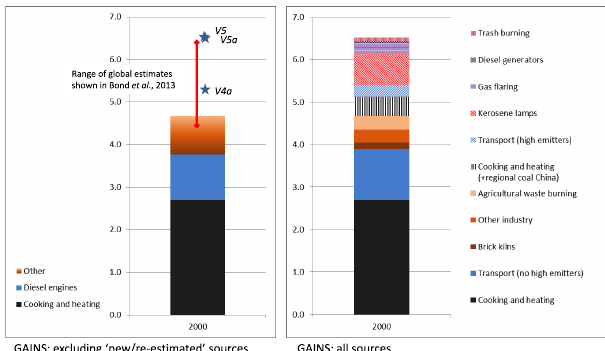
Figure 9. Source-sector distribution of global anthropogenic emis- sion of BC estimated with the GAINS model (ECLIPSE V5a) for the year 2000, Tgyear − 1